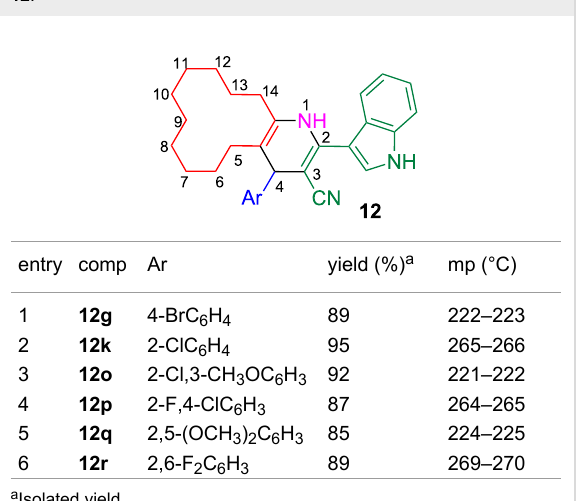
Table 3: Synthesis of indole–cyclododeca[ b ]pyridine-3-carbonitriles 12 .